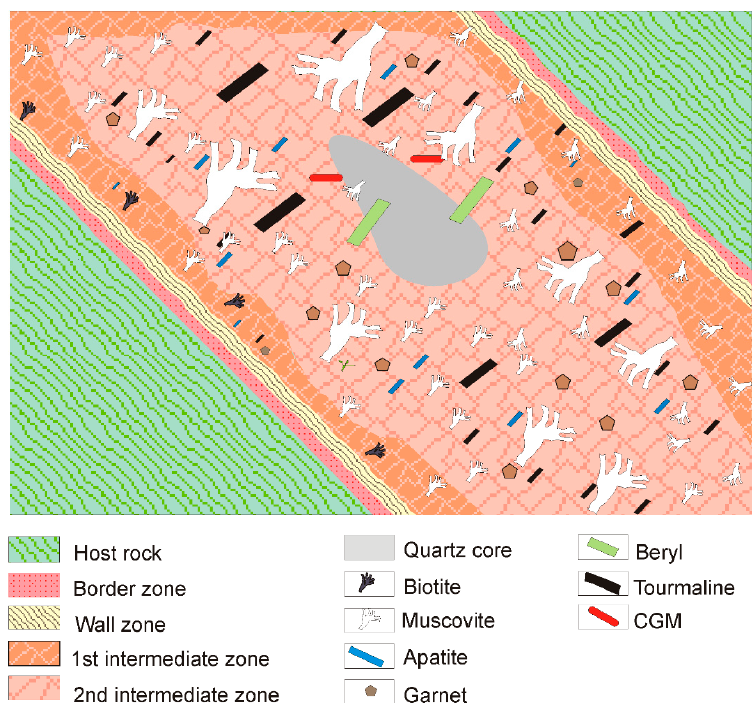
Figure 5. Conceptual scheme (not to scale) showing the pegmatite units in type-II pegmatites and the distribution of the most significant minerals. Minerals 2019 , 9 , 580